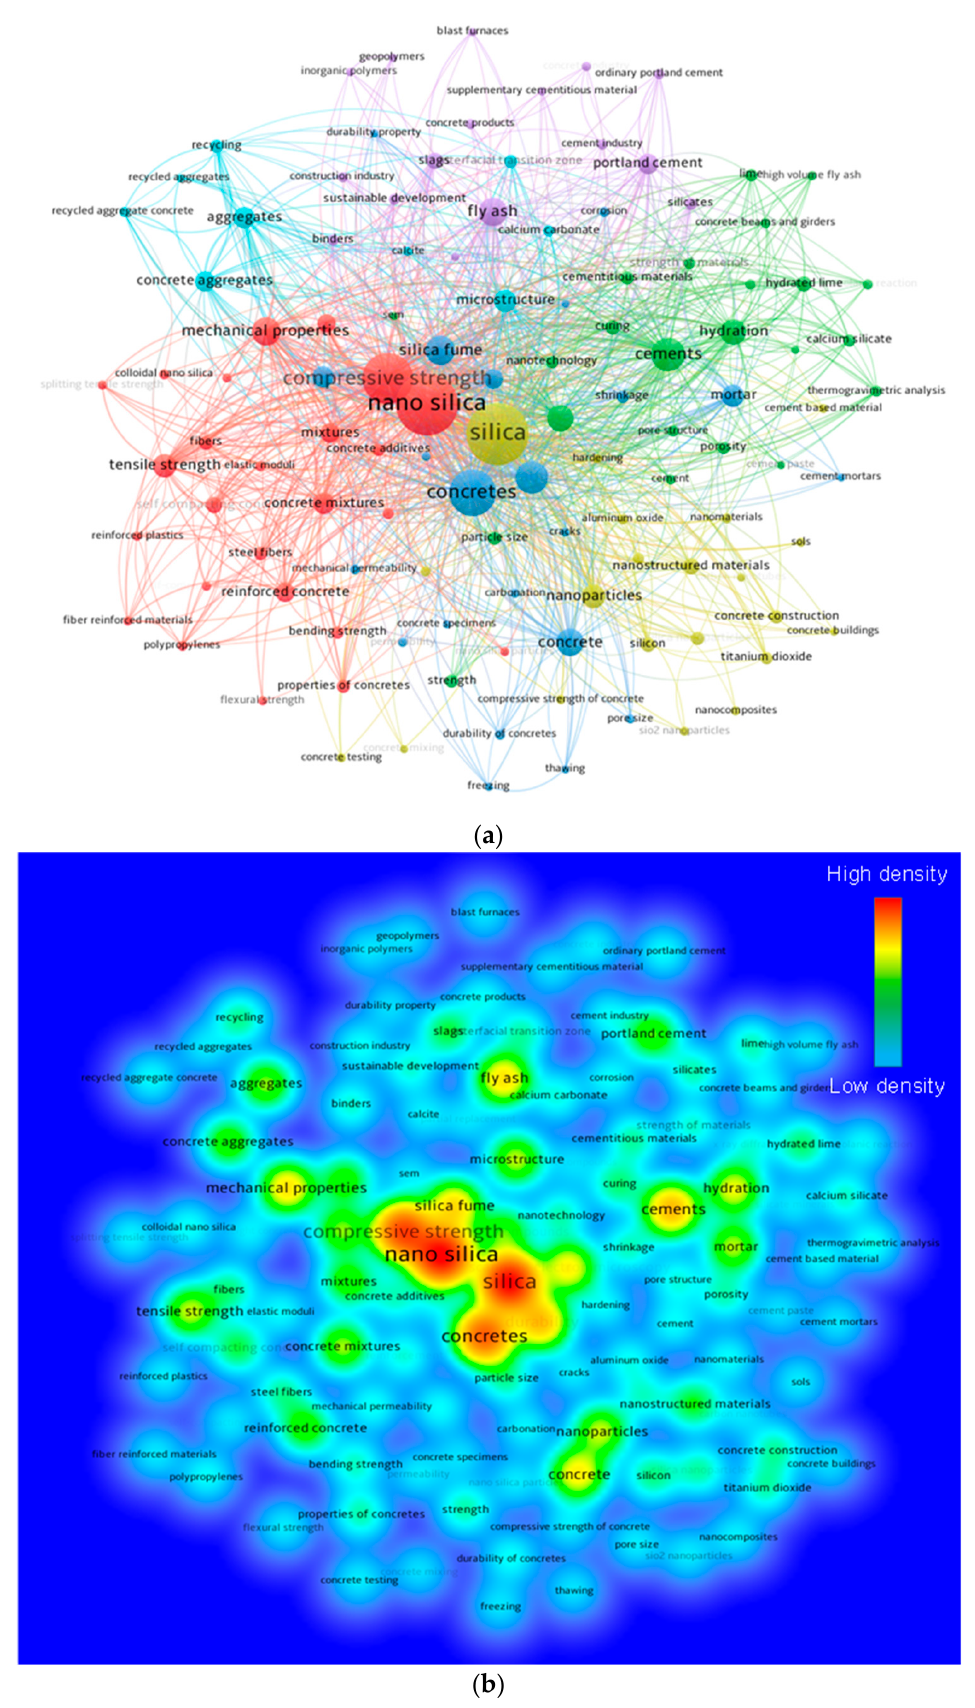
Figure 3. Keywords’ analysis: ( a ) scientific visualization; ( b ) density visualization.